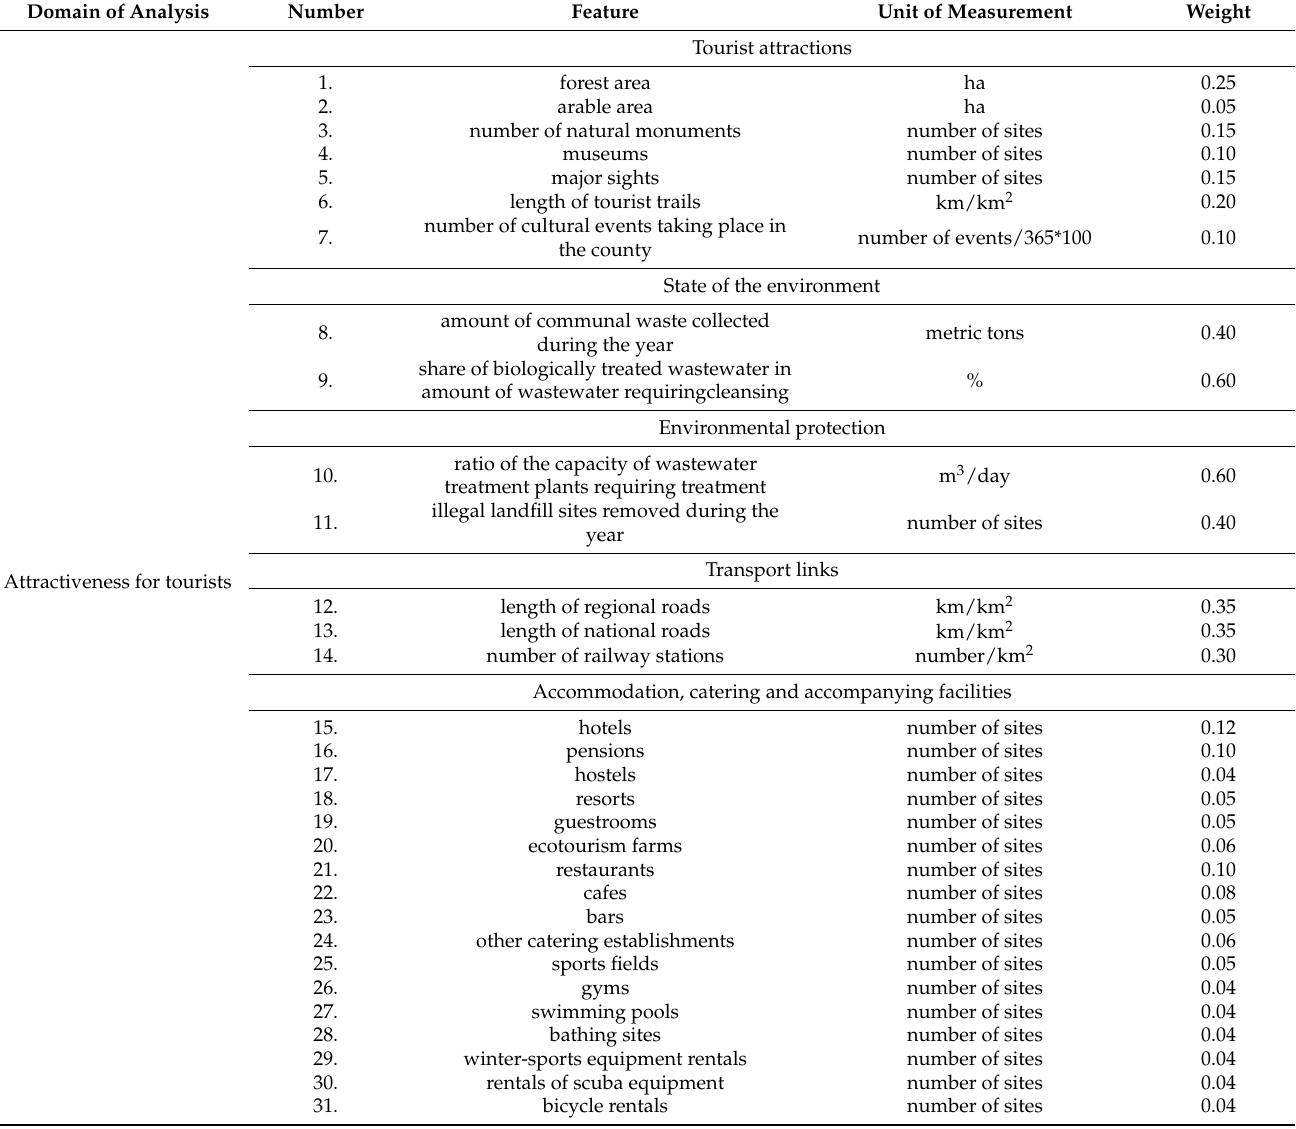
Table 2. Diagnostic features in the domain of attractiveness to tourists and their